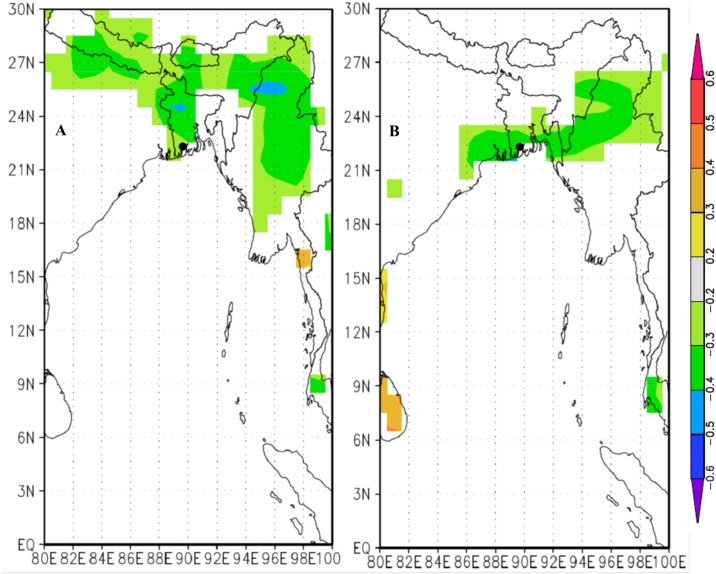
The correlation (1948–2011) between the El Niño 3.4 time-series (gridded 1x1°) and gridded May–July (A), and October–December (B) precipitation (CRU T.S3.0; gridded 1x1°).Black circle indicates the study area. Orange and red colors indicate positive correlations, and green and blue colors indicate negative correlations (p<0.10). The correlation map was created using the KNMI Climate Explorer (The Royal Netherlands Meteorological Institute; http://climexp.knmi.nl/).